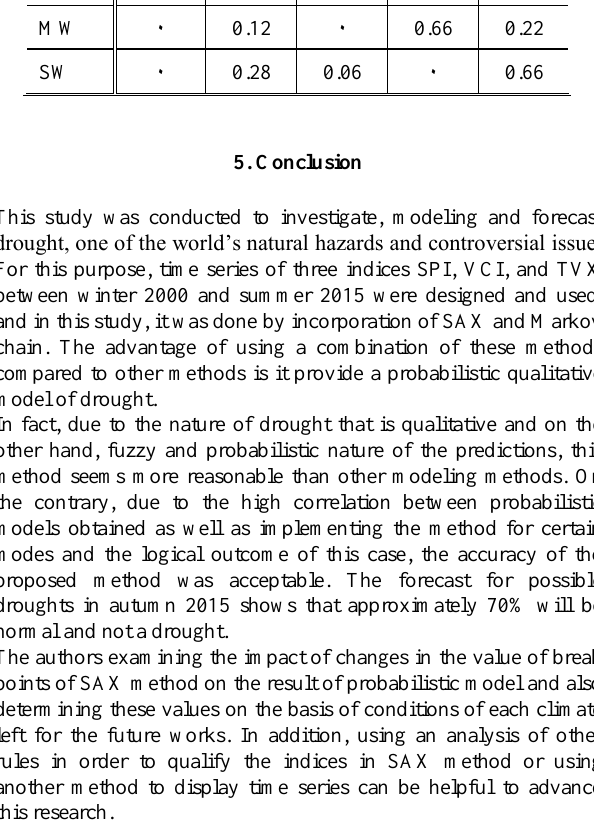
Table III: Probability model for drought based on TVX index SWMWNMDSD 000.3300.66SD 0.010.060.100.790.04MD 0.230.050.660.050N 0.220.6600.120MW